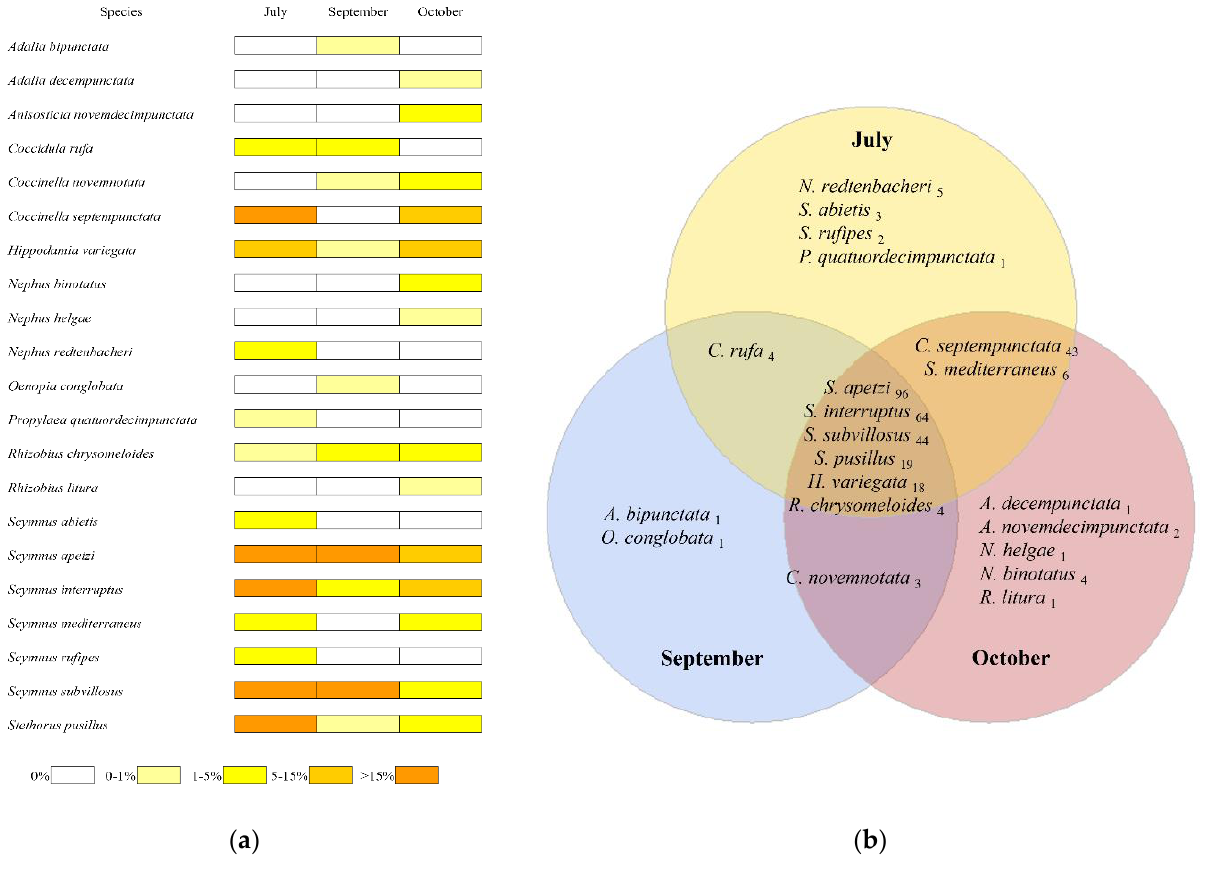
Figure 2. Relative abundance of Coccinellidae species found in the vineyards in July, September, and October ( a ); Venn diagram showing Coccinellidae species in vineyards in July, September, and October. The overlapping areas indicate species shared by two or three dates. The number of specimens (subscripts) is indicated ( b ).